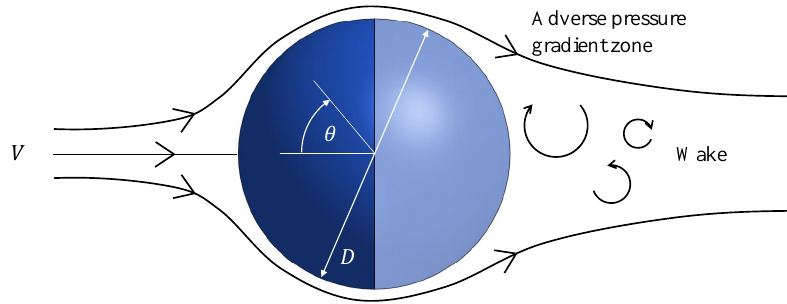
Figure 3. Streamlines around an sphere under a uniform flow.